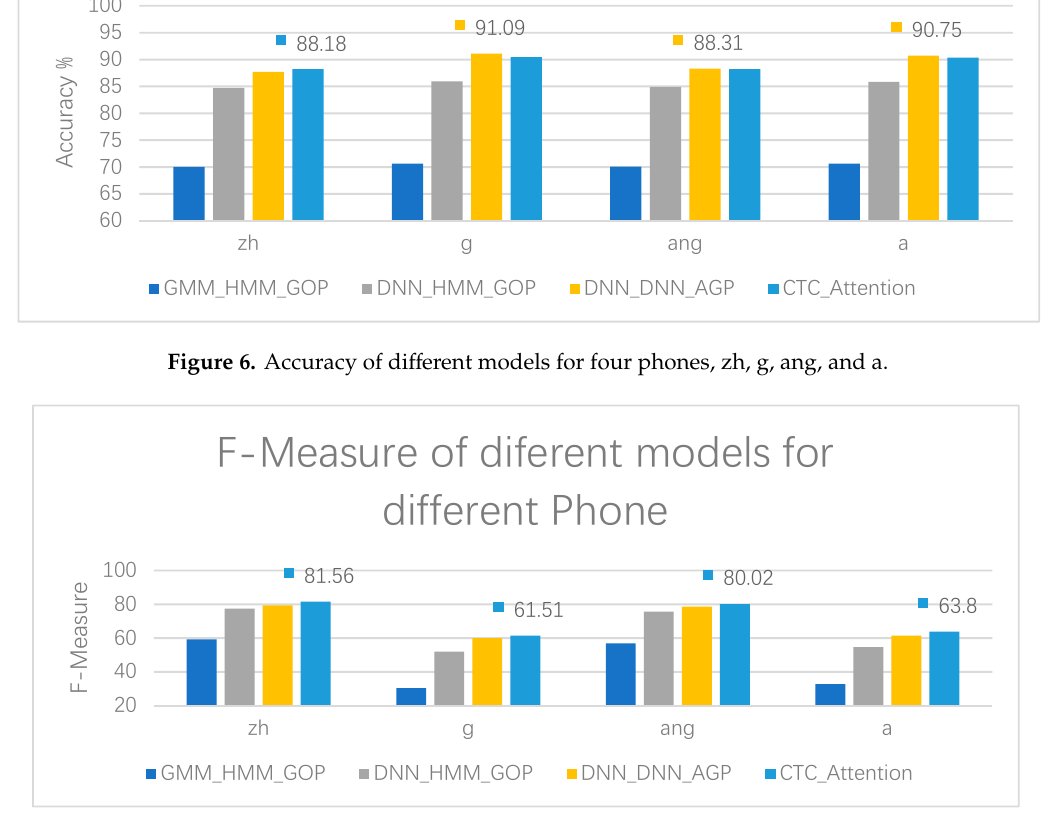
ff erent models for four phones, zh, g, ang, and a. Figure 7. F-Measure of different models for four phones, zh, g, ang, and a. Figure 7. F-Measure of di